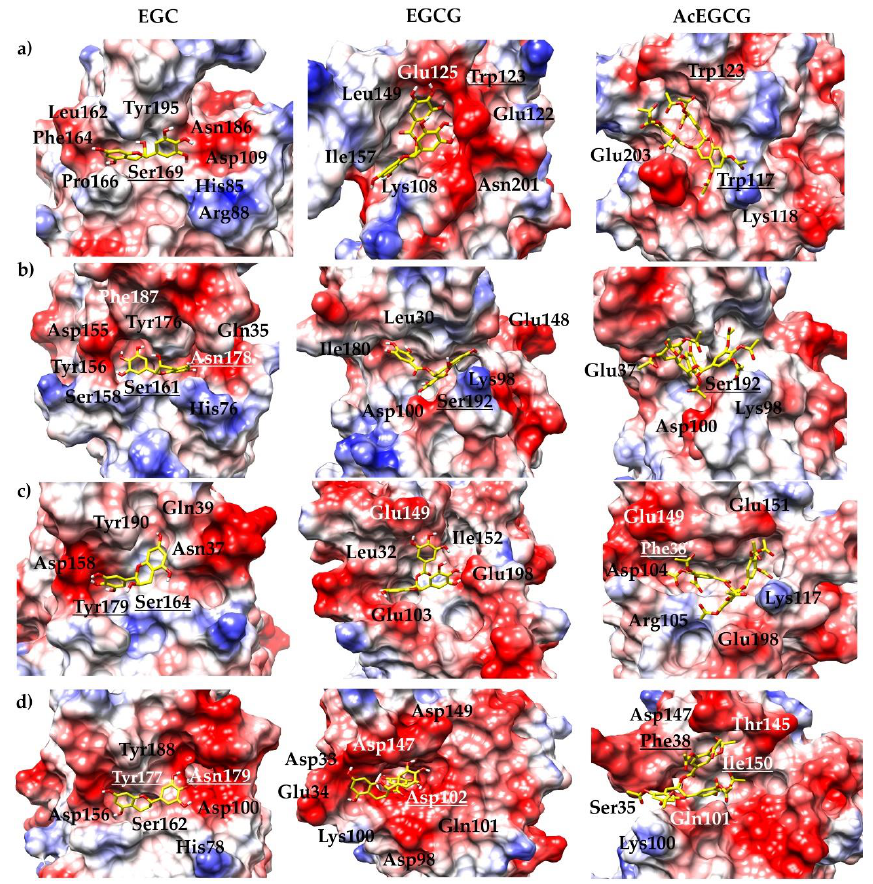
Figure 4. Electrostatic surface potentials of the representative model. The figure is colored red and blue for negative and positive charges, respectively, and white represents neutral residues. The epigallocatechin molecules are shown as yellow sticks. The proteases of ( a ) DENV, ( b ) YFV, ( c ) WNV, and ( d ) ZIKV are shown by the electrostatic surface.